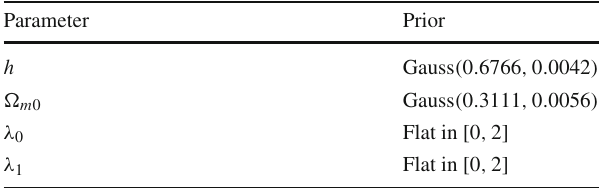
Table 1 Priors used in the MCMC analysis based on references [2,36]. Based on results in [36], the parameter n is fixed at n = − 2 Parameter Prior h Gauss ( 0 . 6766 , 0 . 0042